Question: Provide a publication-style caption for this figure.
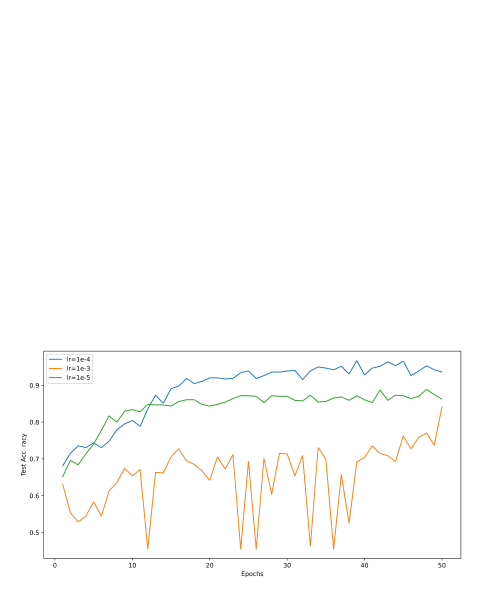
Answer: Accuracy under different learning rates.